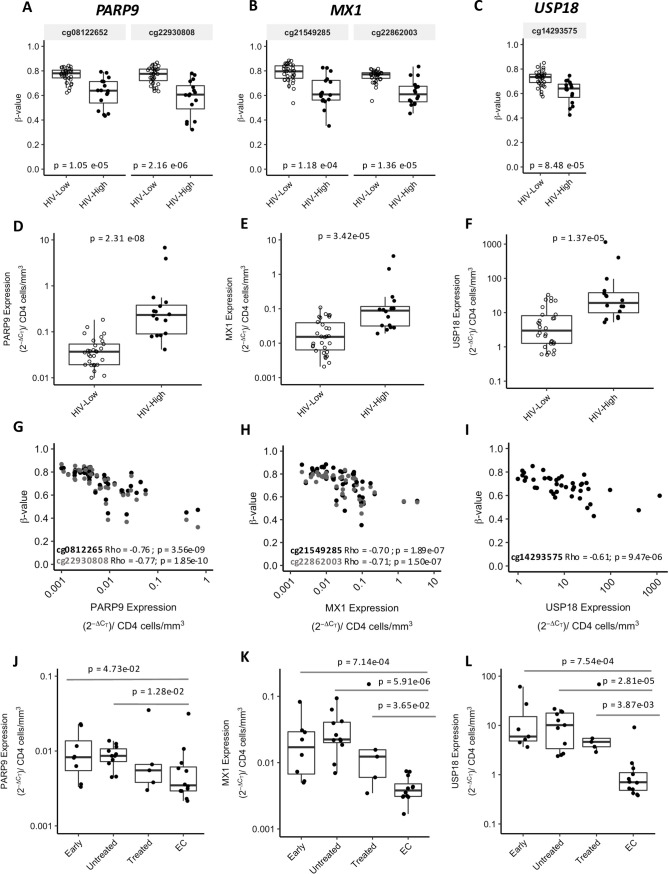
Epigenetic regulation confirmation of selected candidates and gene expression validation in unrelated cohorts.Boxplot for PARP9 (A), MX1 (B) and USP18 (C) with the Beta-values in Y-axis and the HIV-High (n = 15) or HIV-Low (n = 31) groups in X-axis. (D-F) Boxplots of the transcriptional levels of PARP9 (D), MX1 (E) and USP18 (F) analyzed by qRT-PCR, and represented here as the 2-ΔCT method corrected by the number of CD4 counts in HIV-Low (n = 31) and HIV-High (n = 15). (G-I) Correlation plots, showing the inverse correlation between Beta-values of DMPs and the corresponding gene expression level PARP9 (G), MX1 (H) and USP18 (I). (J-L) Boxplots indicating the gene expression level of PARP9 (J), MX1 (K) and USP18 (L) in the independent cohorts of HIV-1 infection: Early (Early infected untreated individuals, n = 8), Untreated (Chronic infected untreated individuals, n = 11), Treated (Chronic infected cART treated individuals, n = 5) and EC (Elite Controllers, n = 12). Mann Whitney test was applied for groups’ comparisons and Spearman’s rank correlation test, for correlation analysis. In all the cases, p-values <0.05 were considered significant.